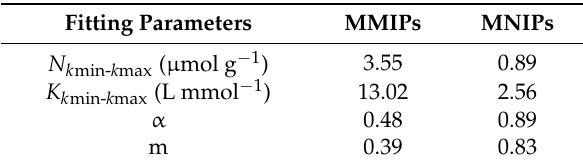
Table 1. Freundlich fitting parameters, number of binding sites ( N kmin-kmax ) and weighted average